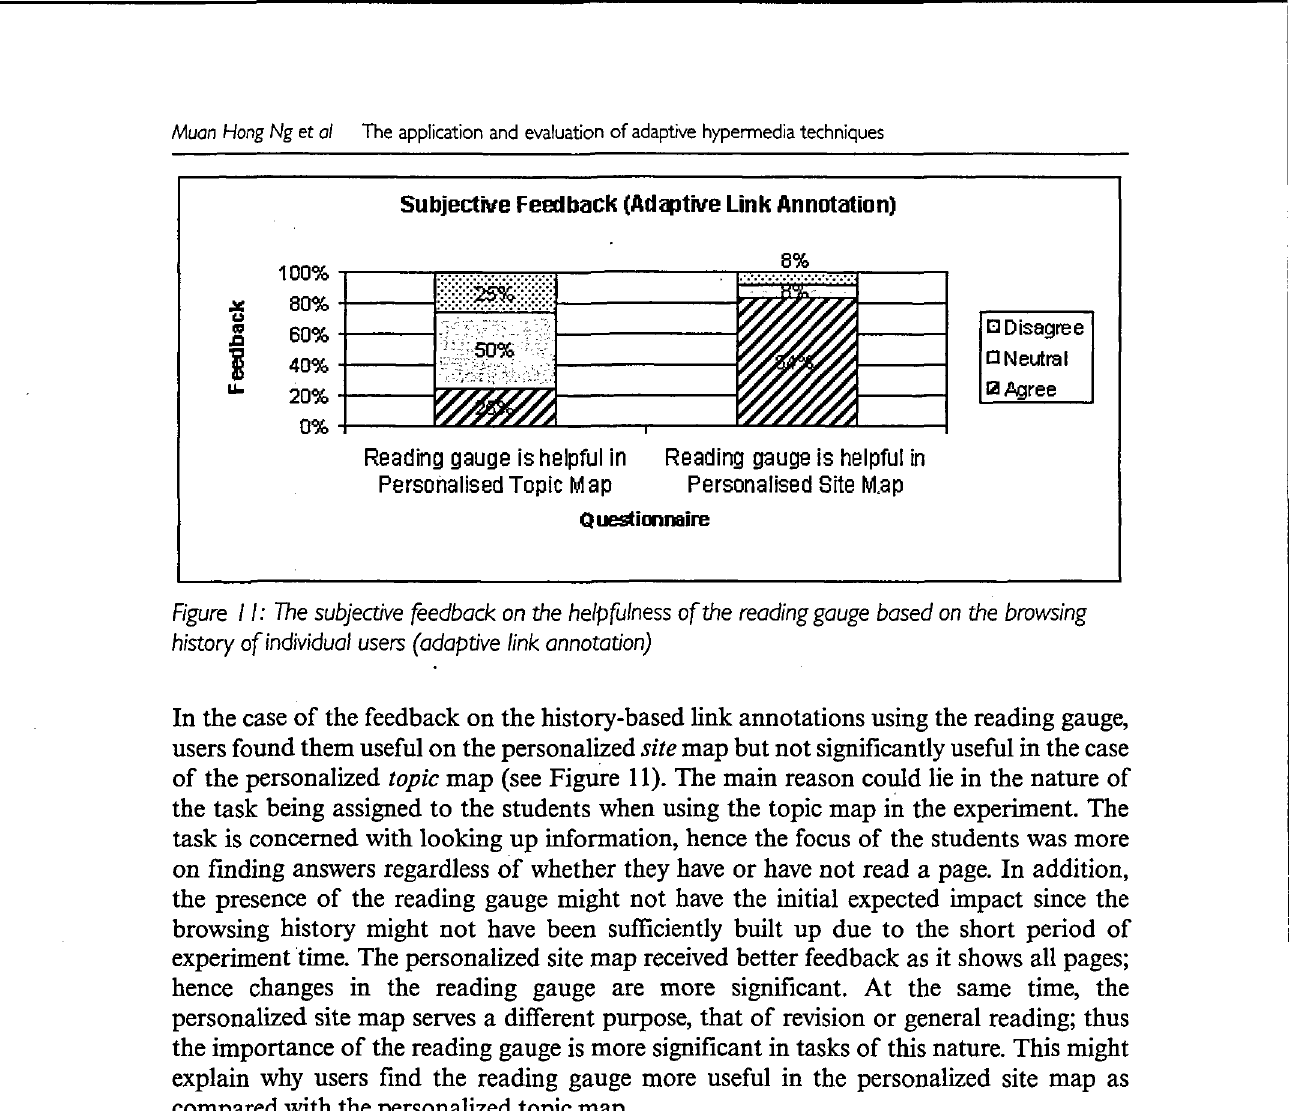
Figure 11: The subjective feedback on the helpfulness of the reading gauge based on the browsing history of individual users (adaptive link